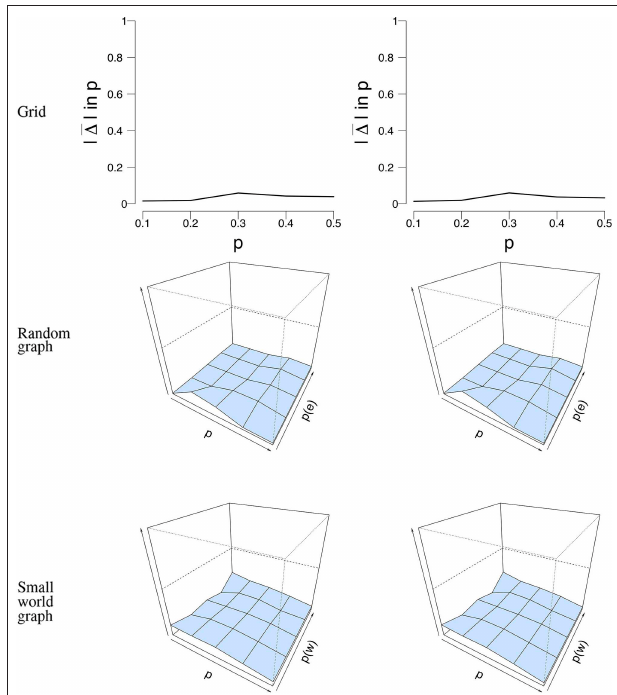
FIGURE 8 | Visualization of the mean absolute differences between p and ˆ p that resulted from the subset analysis with n = 100 nodes and T = 50 time points. The rows denote the structure under which the data were simulated and analyzed. The left column shows the result for the subset analysis with 50 % of the data retained, while the right column shows the results with 75 % of the data retained. The x -axis denotes the parameter p for which we simulated data, the z -axis the graph parameter that was used to simulate data (in case of the 3D figures), and the y -axis the mean absolute difference between p and ˆ p . The mean absolute difference ranges between 0 and 1, where a lower value indicates a smaller difference between p and ˆ p